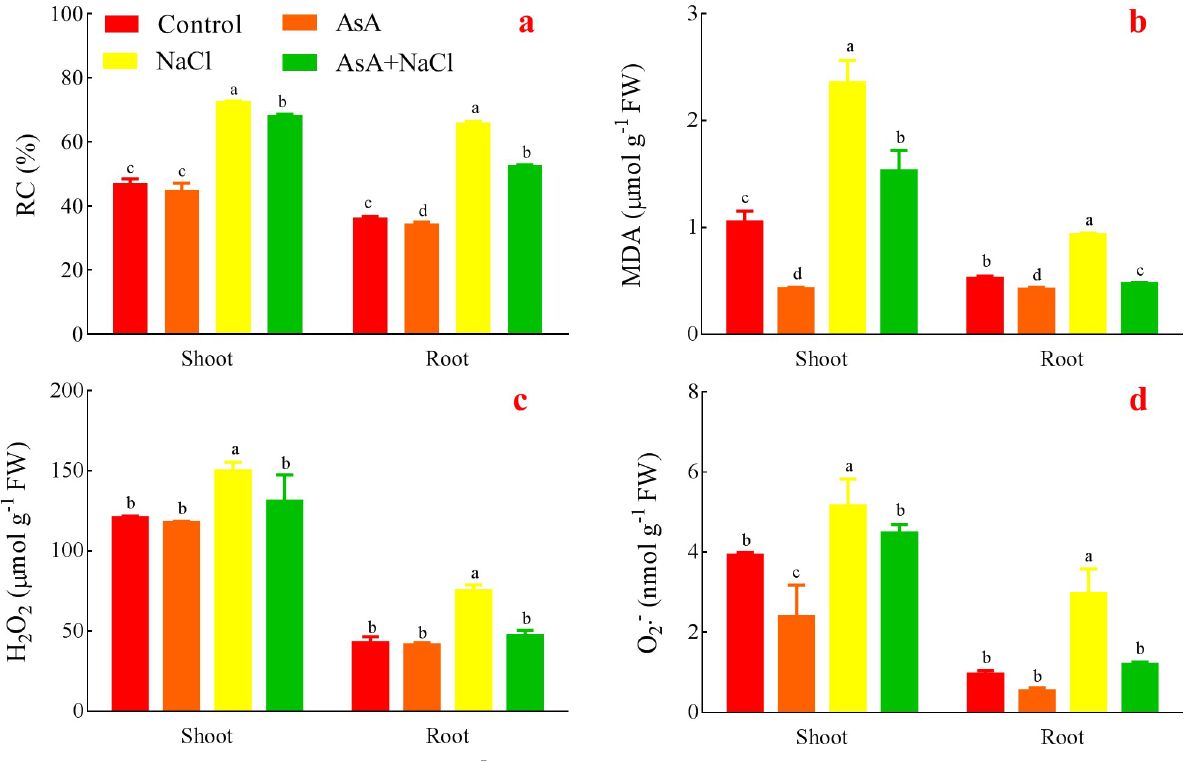
Fig 5. Effects of AsA on RC (a), MDA (b), H 2 O 2 (c), and O 2 � � (d).